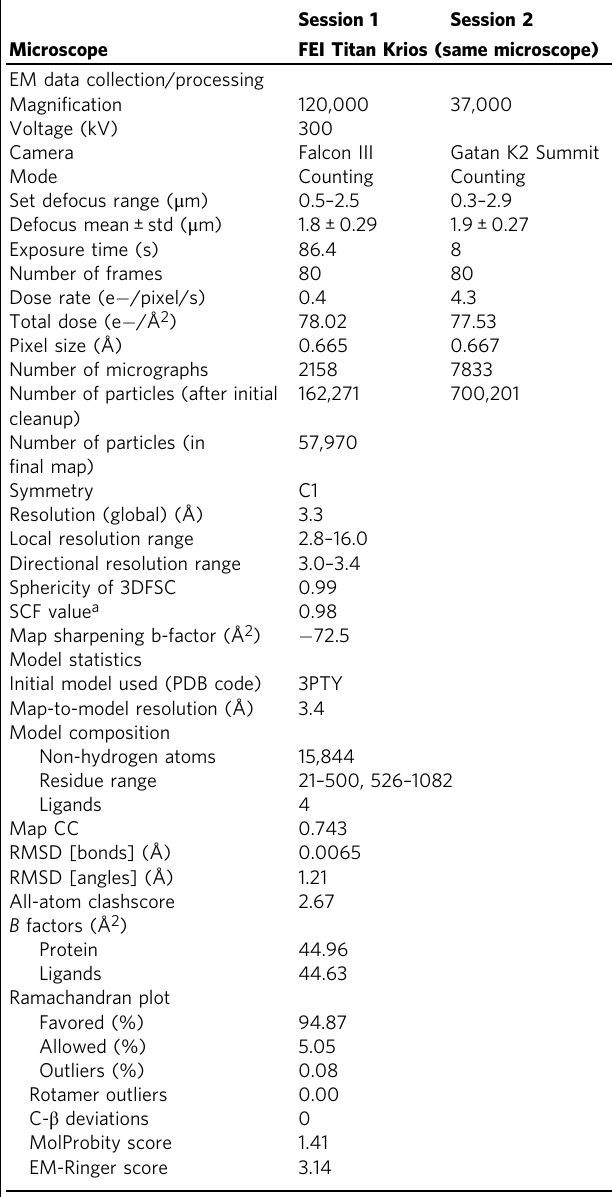
Table 1 Cryo-EM data collection and modeling statistics